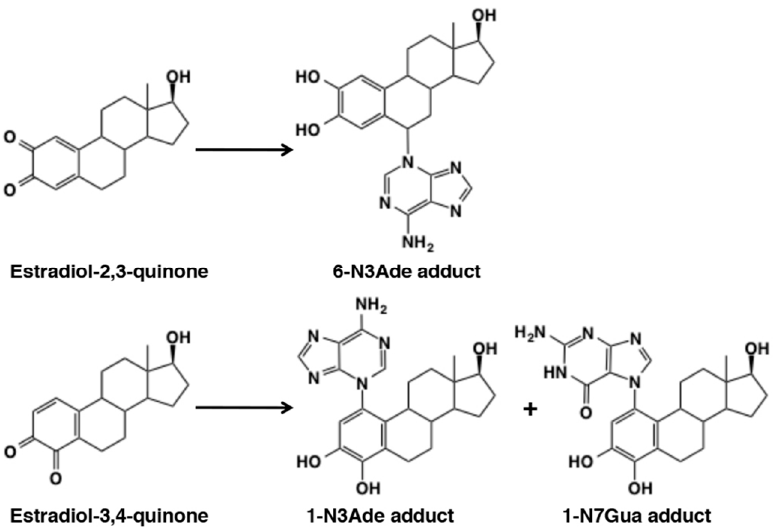
Figure 26. Reaction of β -estradiol quinones with DNA to produce depurinating products [134].